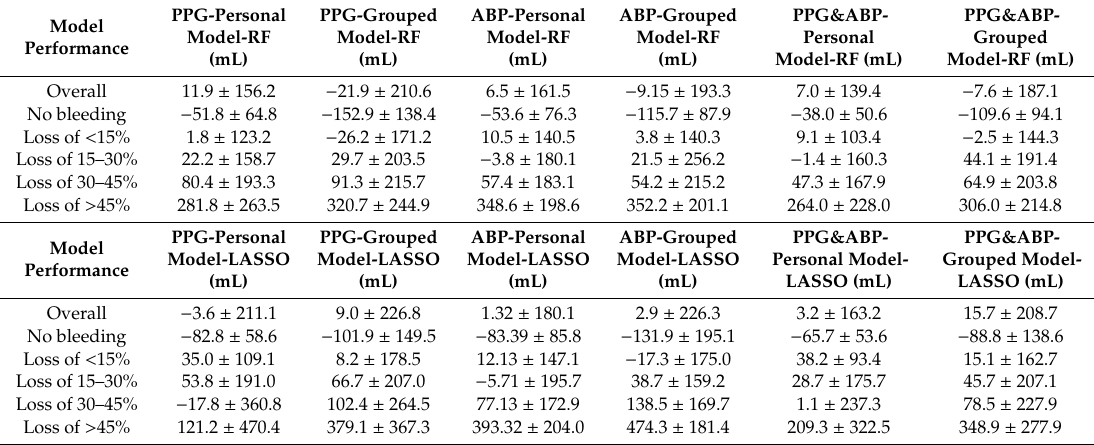
Table 1. Models’ performances in di ff erent blood loss severities.